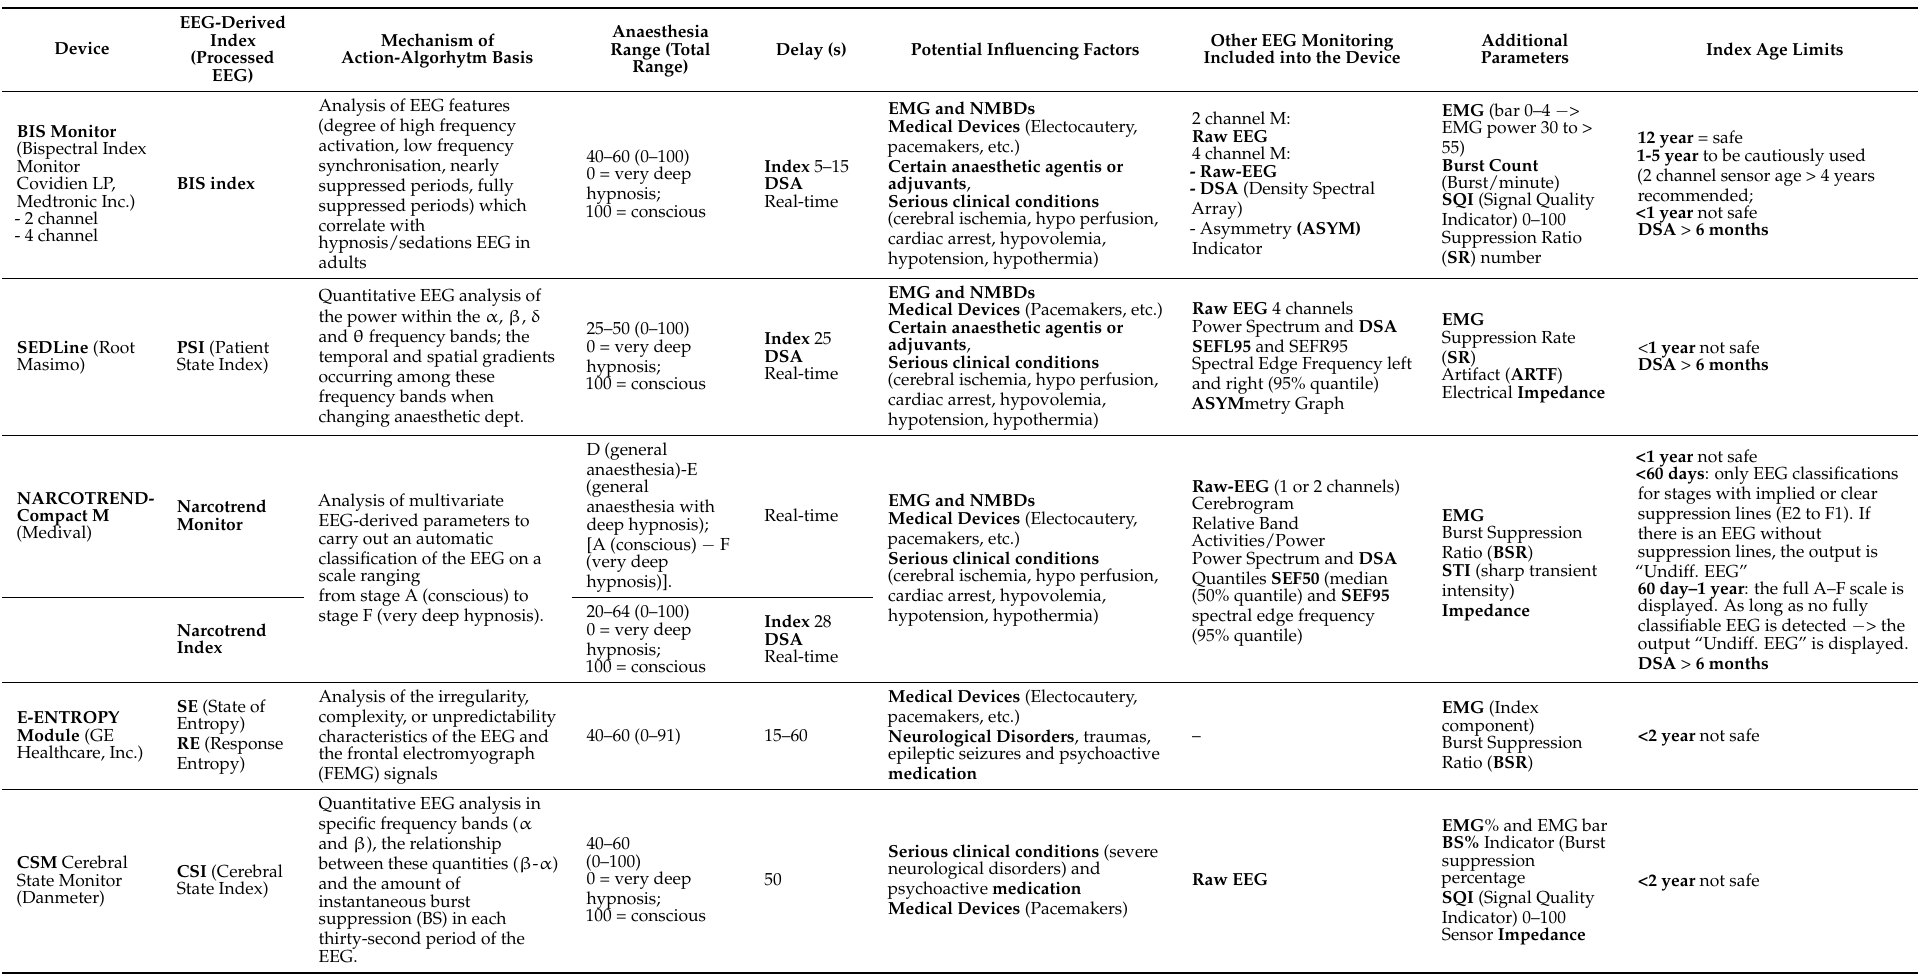
Table 1. The most widely used EEG-based anaesthesia monitoring devices currently available, their key features and age limits for their safe use. EEG Electroencephalogram; NMBs Neuromuscular Blockers; EMG Electromyography; DSA Density Spectral Array; not safe = no studies demonstrate its accuracy and reliability in this age